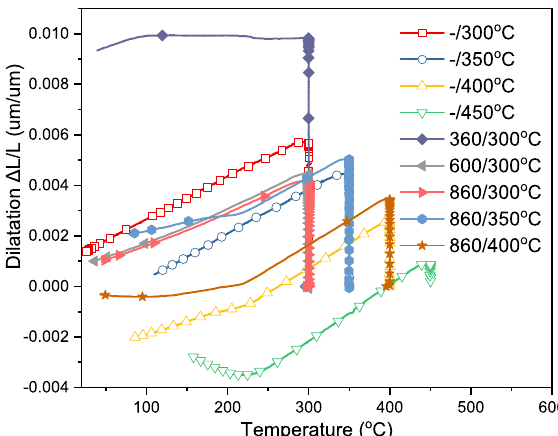
Figure 4. Dilatation ∆ L / L at specific isothermal temperature and in subsequent cooling